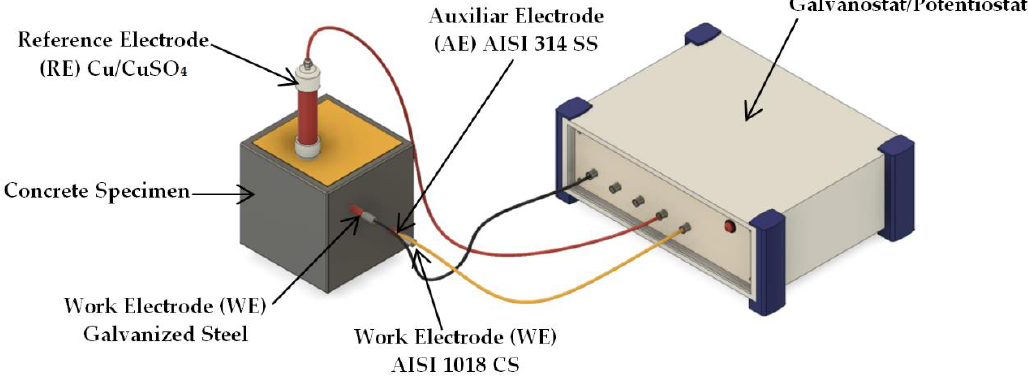
Figure 3. Electrochemical cell for the monitoring of corrosion.